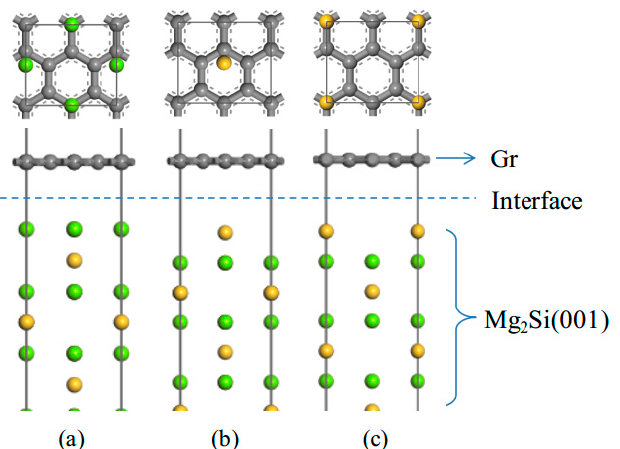
Figure 3. Interfacial atom stacking site and interfacial model of Mg 2 Si (001)/Gr (0001) interface: ( a ) Mg-termination; ( b ) Si-termination-center-sited; ( c ) Si-termination-top-sited (the green ball represents Mg atom, the yellow ball represents Si atom, the gray ball represents C atom).